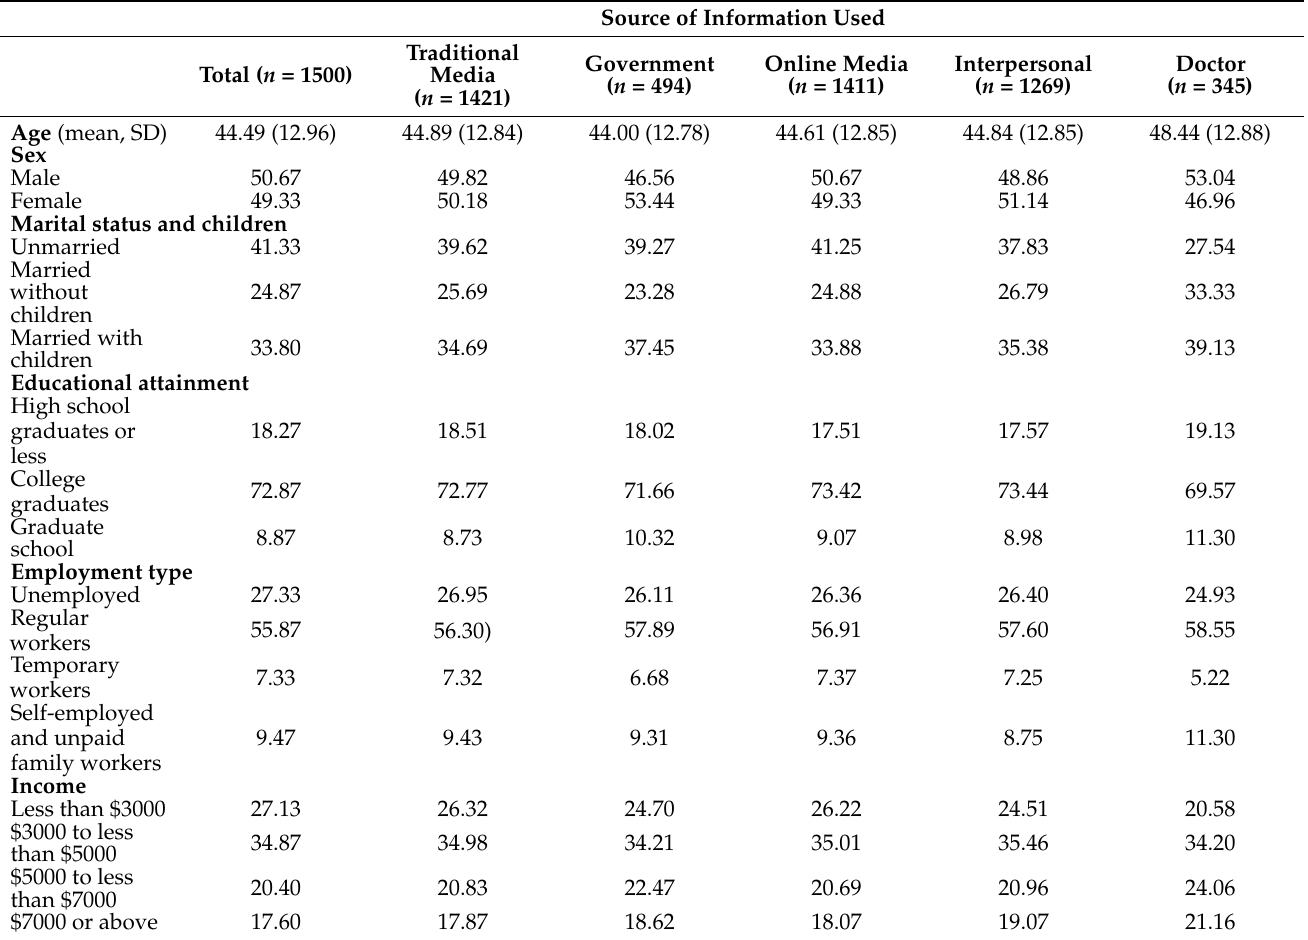
Table 2. Characteristics of 1500 participants with data on COVID-19 sources of information, December 2020, %. Source of Information